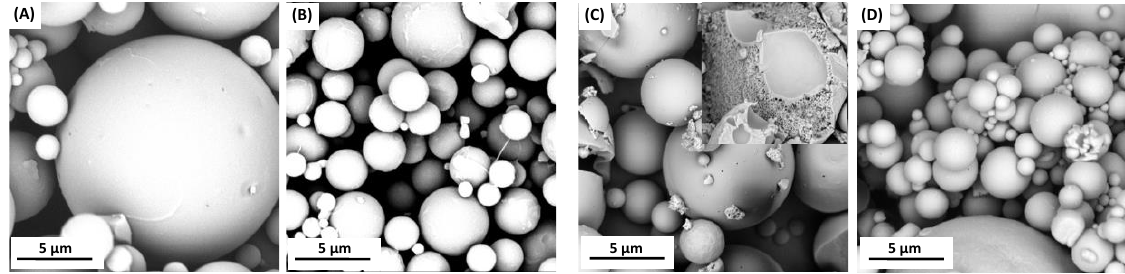
Figure 6. Scanning electron microscope (SEM) images of polyDBB_PEG_250_20 microspheres obtained by using homogenization speed of 3000 rpm ( A ) and 18,000 rpm ( B ) and polyDBB_PEG_250_40 microspheres obtained by using homogenization speeds of 3000 rpm ( C ) and 18,000 rpm ( D ).